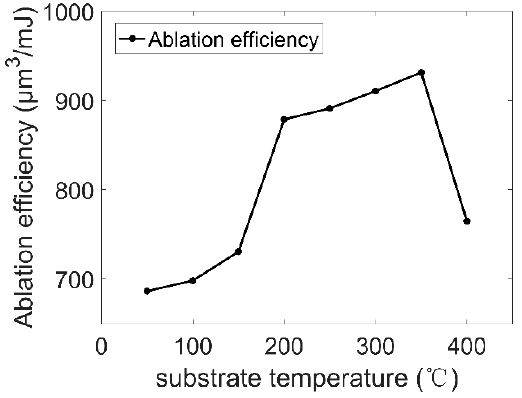
Figure 7. Relationship between ablation efficiency ω and substrate temperature.